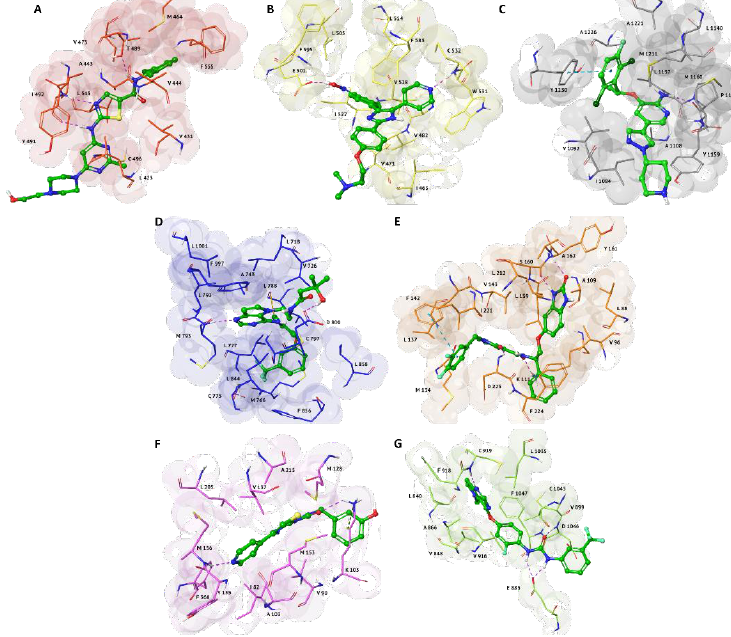
Figure 2. 3D representations of the best docking pose of cinnamyl cinnamate with the following anti-cancer targets: ( A ) EGFR (PDB: 3POZ), represented as blue surface; ( B ) PDK1 (PDB: 3NAX), represented as orange surface; ( C ) c-Met (PDB: 2WGJ), represented as grey surface; ( D ) BMX (PDB: 3SXR), represented as red surface; ( E ) B-Raf (PDB: 2FB8), represented as yellow surface. Ligands are shown in green carbon ball-and-sticks, while amino-acid residues involved in the molecular interactions are shown as carbon sticks with the correspondent color of protein’s surface. H-bonds and π-π interactions are displayed as purple and cyan dashed lines, respectively.